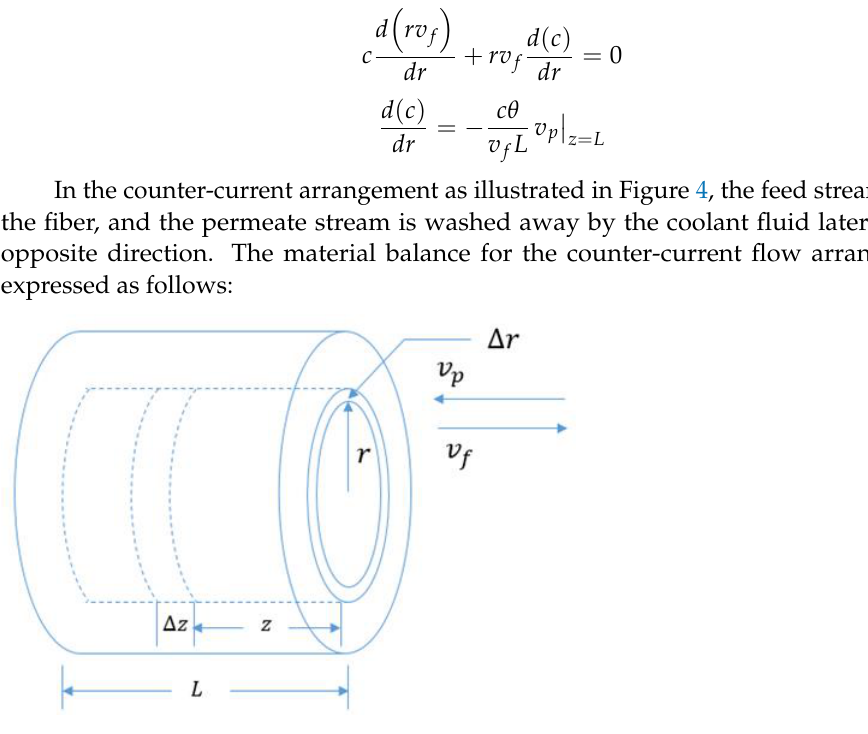
Figure 4. Differential material balance in a hollow fiber MD module with counter-current flow.